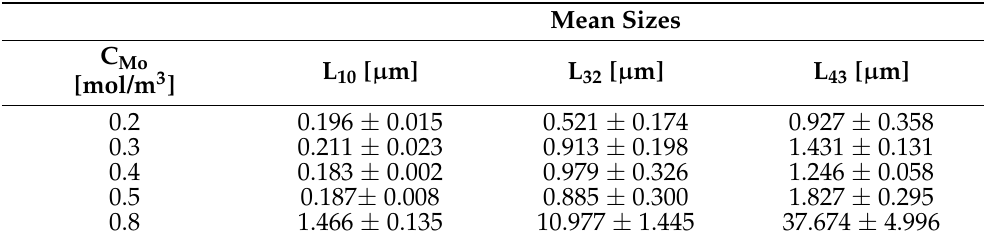
Table 3. Mean sizes depending on the initial molybdenum